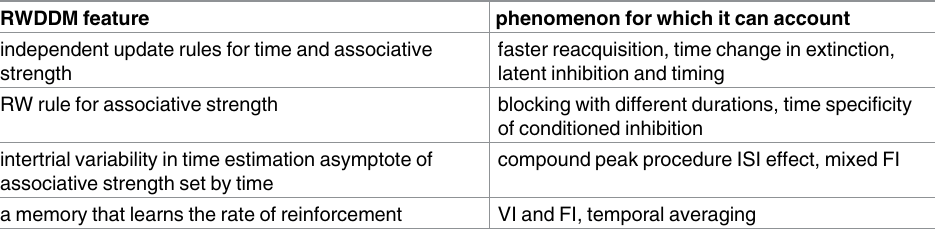
Table 2. Model featuresand the experimental findings they can